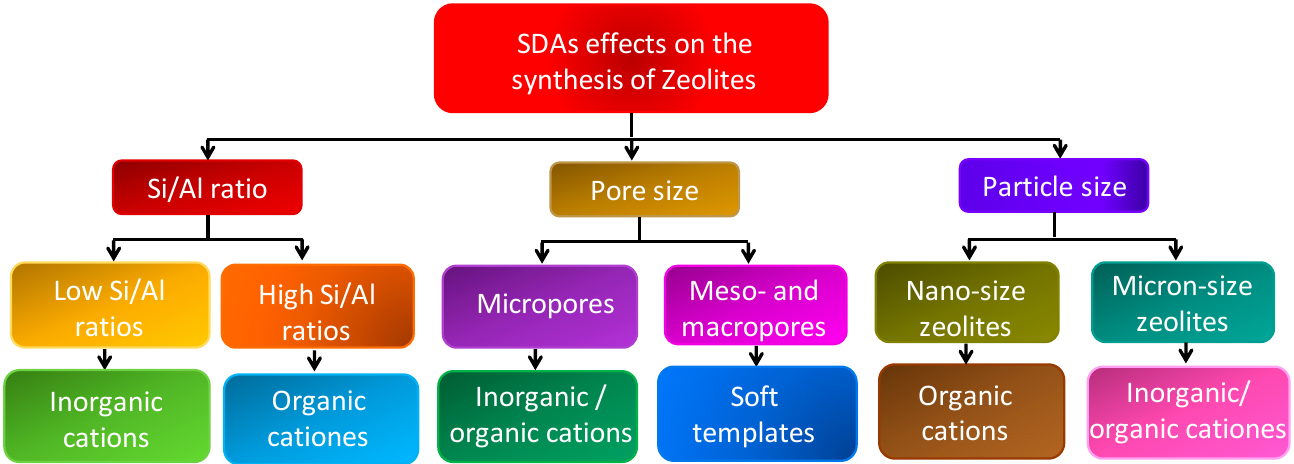
Figure 1. The effects of SDAs on the physicochemical properties of zeolites. 2. Effects of SDAs on the Chemical Composition of Zeolites (or Si/Al